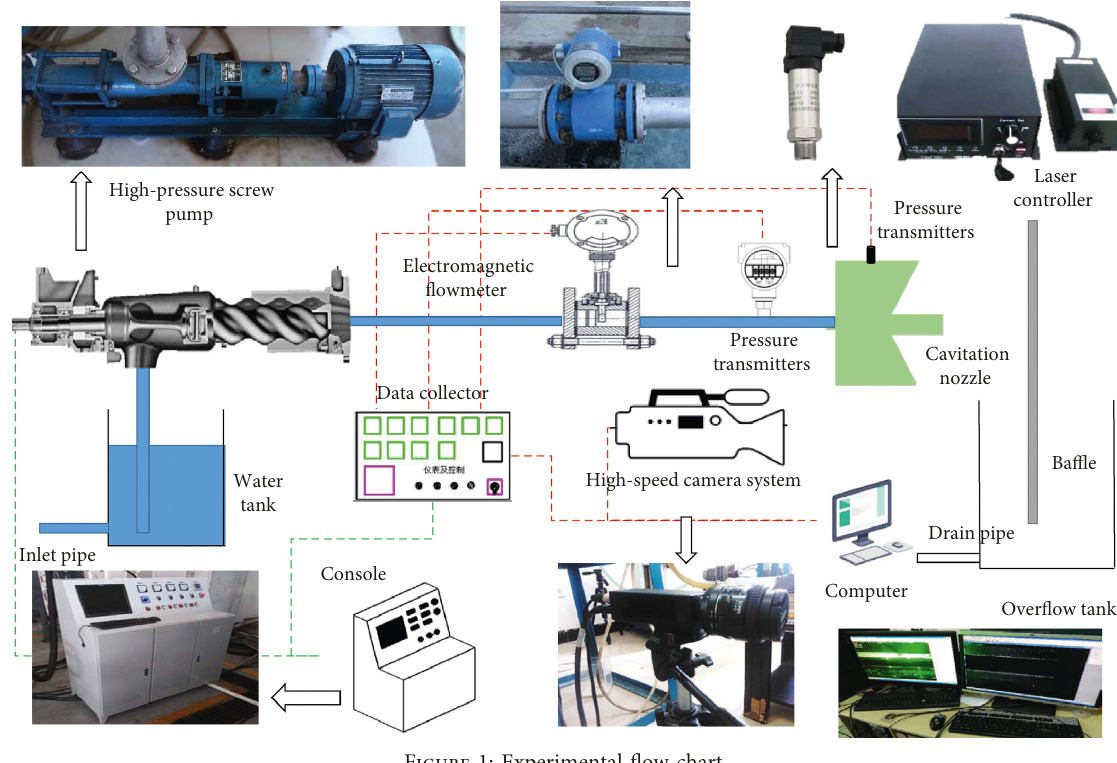
Figure 1: Experimental flow chart.